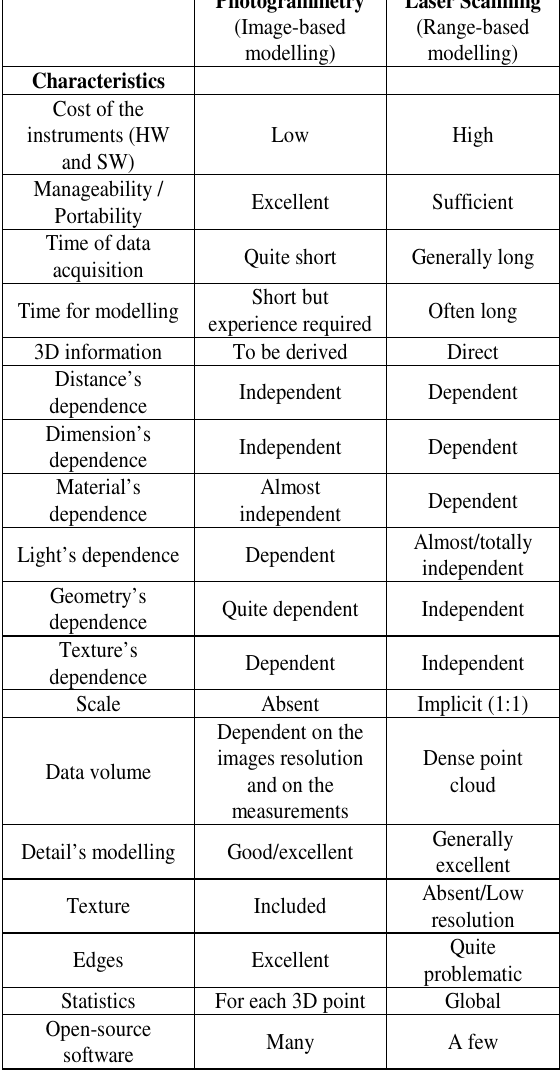
Table 2. Synthesis of photogrammetry and laser scanning techniques and